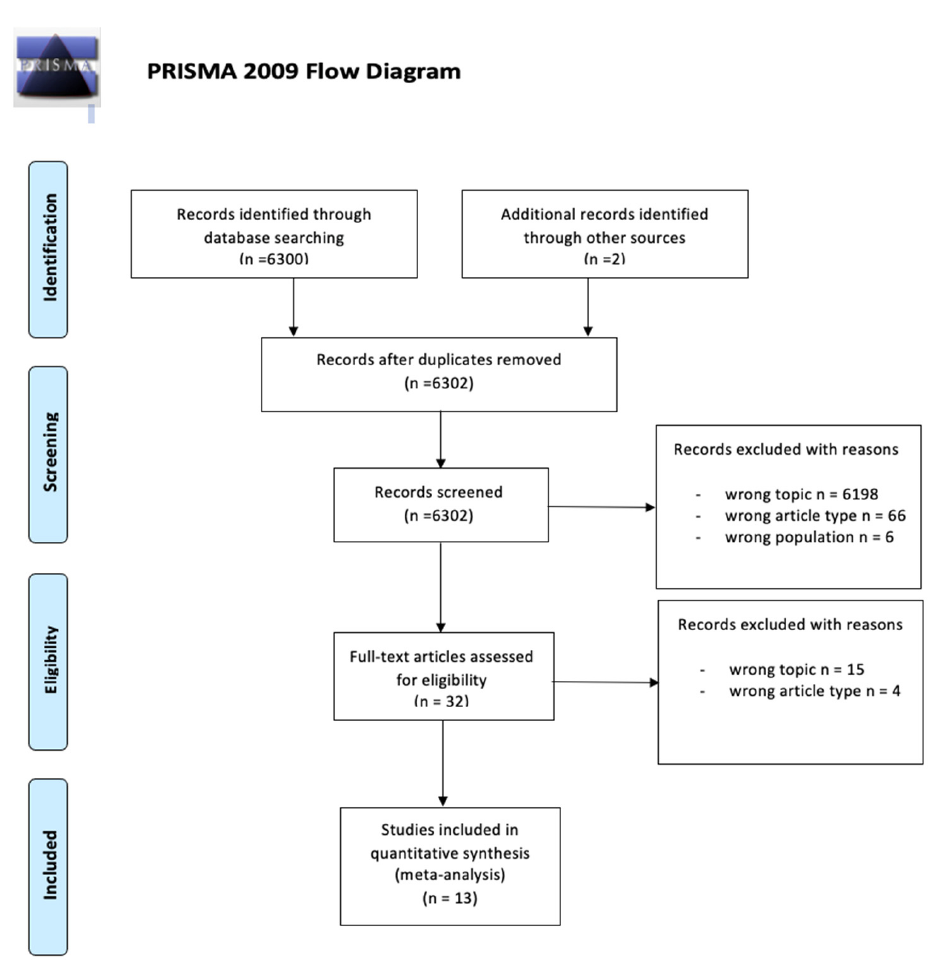
Figure 1. Flow diagram of the study according to Preferred Reporting Items for Systematic Reviews and Meta-Analyses (PRISMA) guidelines [7].